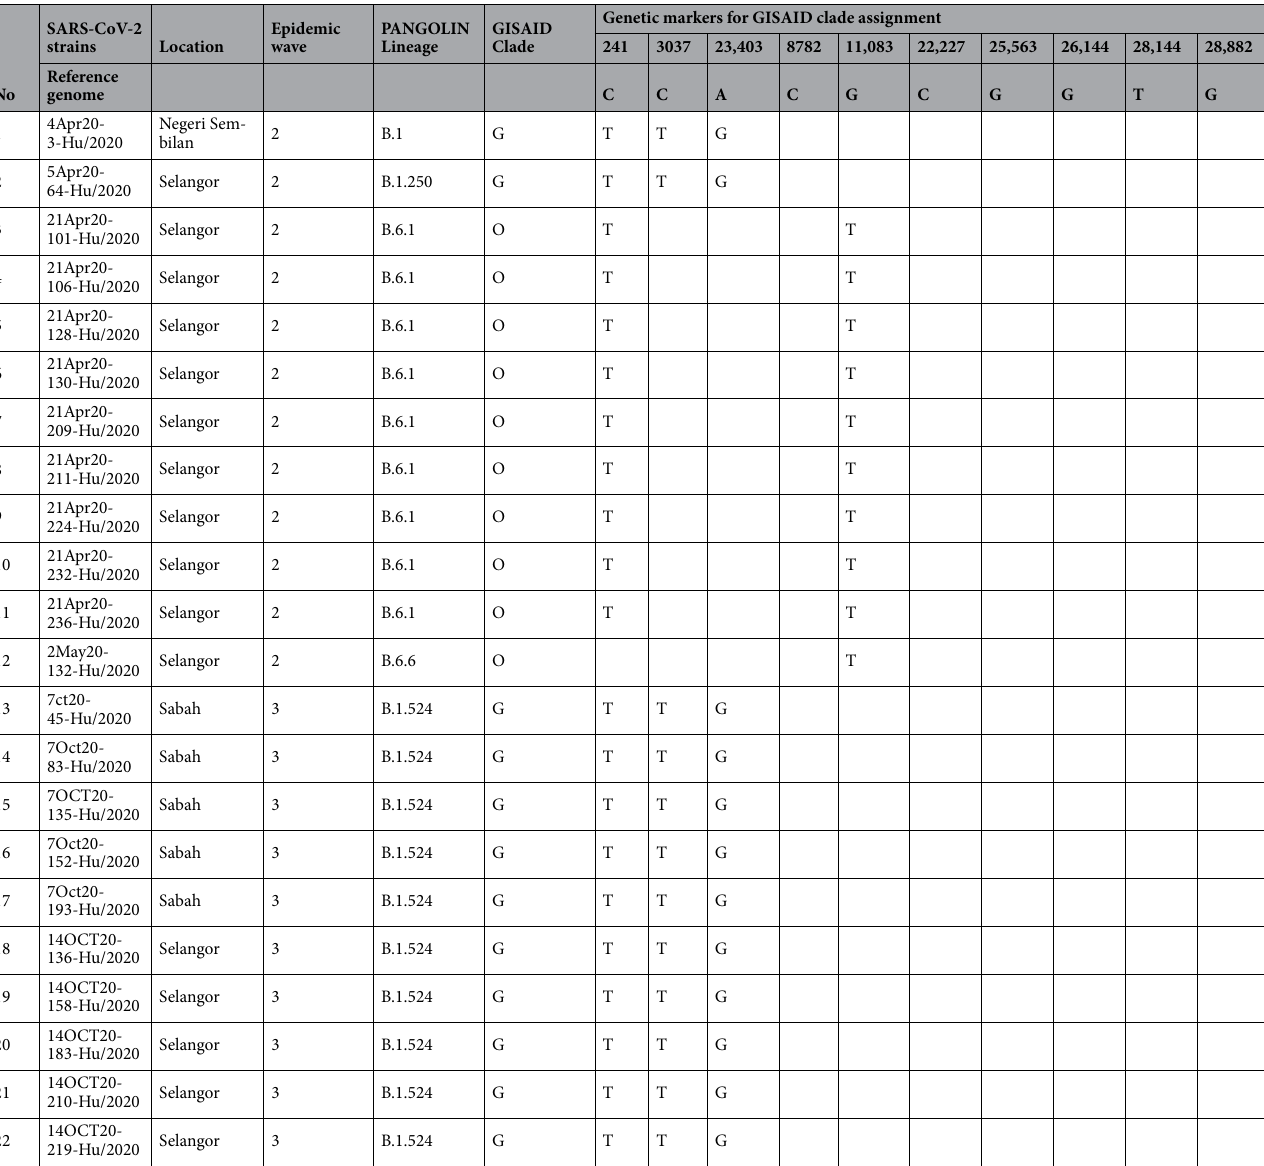
Table 1. Clade and lineage assignments of SARS-CoV-2